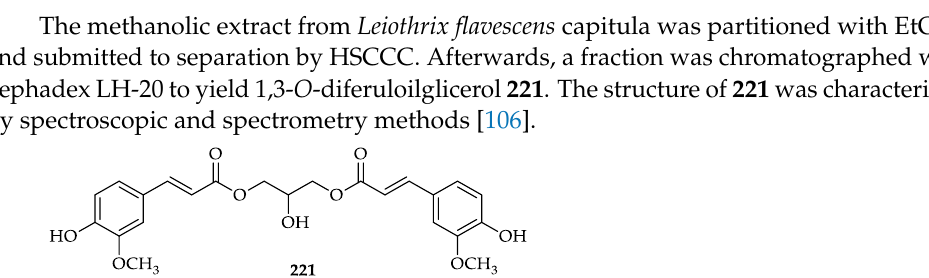
Table 8. Phenolic acids derivatives isolated from Eriocaulaceae species.